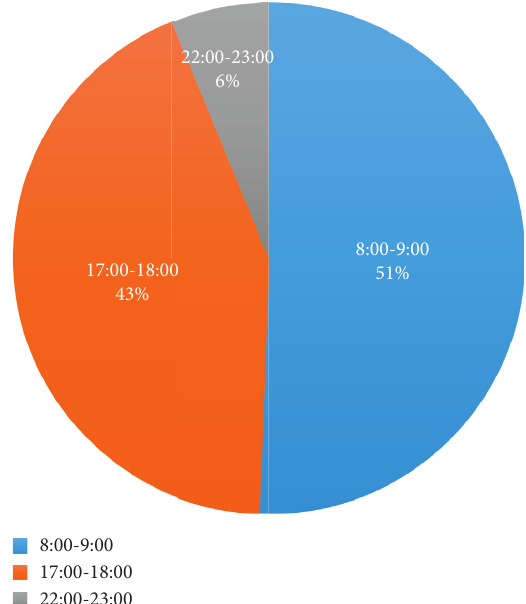
Figure 4: Distribution of illegal parking in different periods on the first